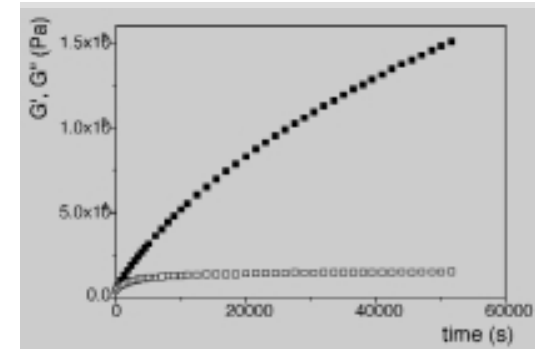
moduli of pure components at the same temperature: MAH1 ( · ), GMA1 ( Á ). Figure 9 (right): Storage ( ‚ ) and loss ( · ) modulus at 0.1 rad/s versus reaction time at 180°C for the experimen- tal conditions of Fig.